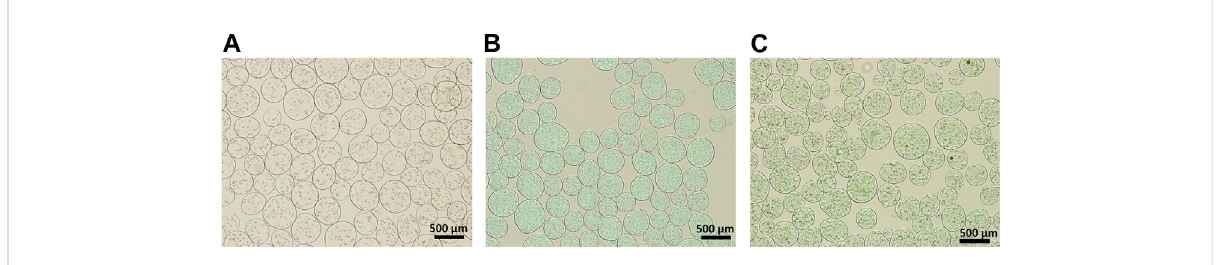
FIGURE 2 Optical images of the 1:1 ratio of cell-encapsulated alginate/different composite hybrid microspheres. (A) Alginate with cell (without HAp nor quercetin) (B) alginate:HAp; and (C) alginate:8 wt% quercetin-preloaded